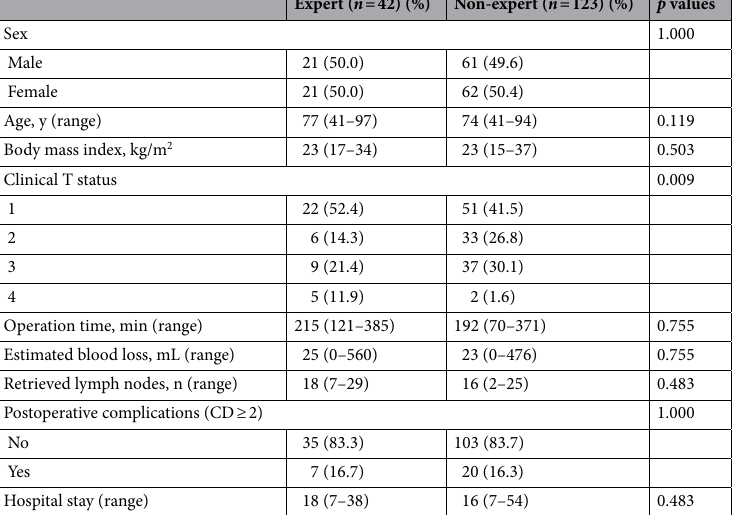
Table 5. Comparison of clinical characteristics in LAC performed by an expert or a non-expert. Data are presented as numbers of patients or medians (range). Differences in categorical variables were compared using Fisher’s exact test or the chi-squared test, as appropriate. Differences in continuous variables were analyzed with the Mann–Whitney U -test. LAC laparoscopic